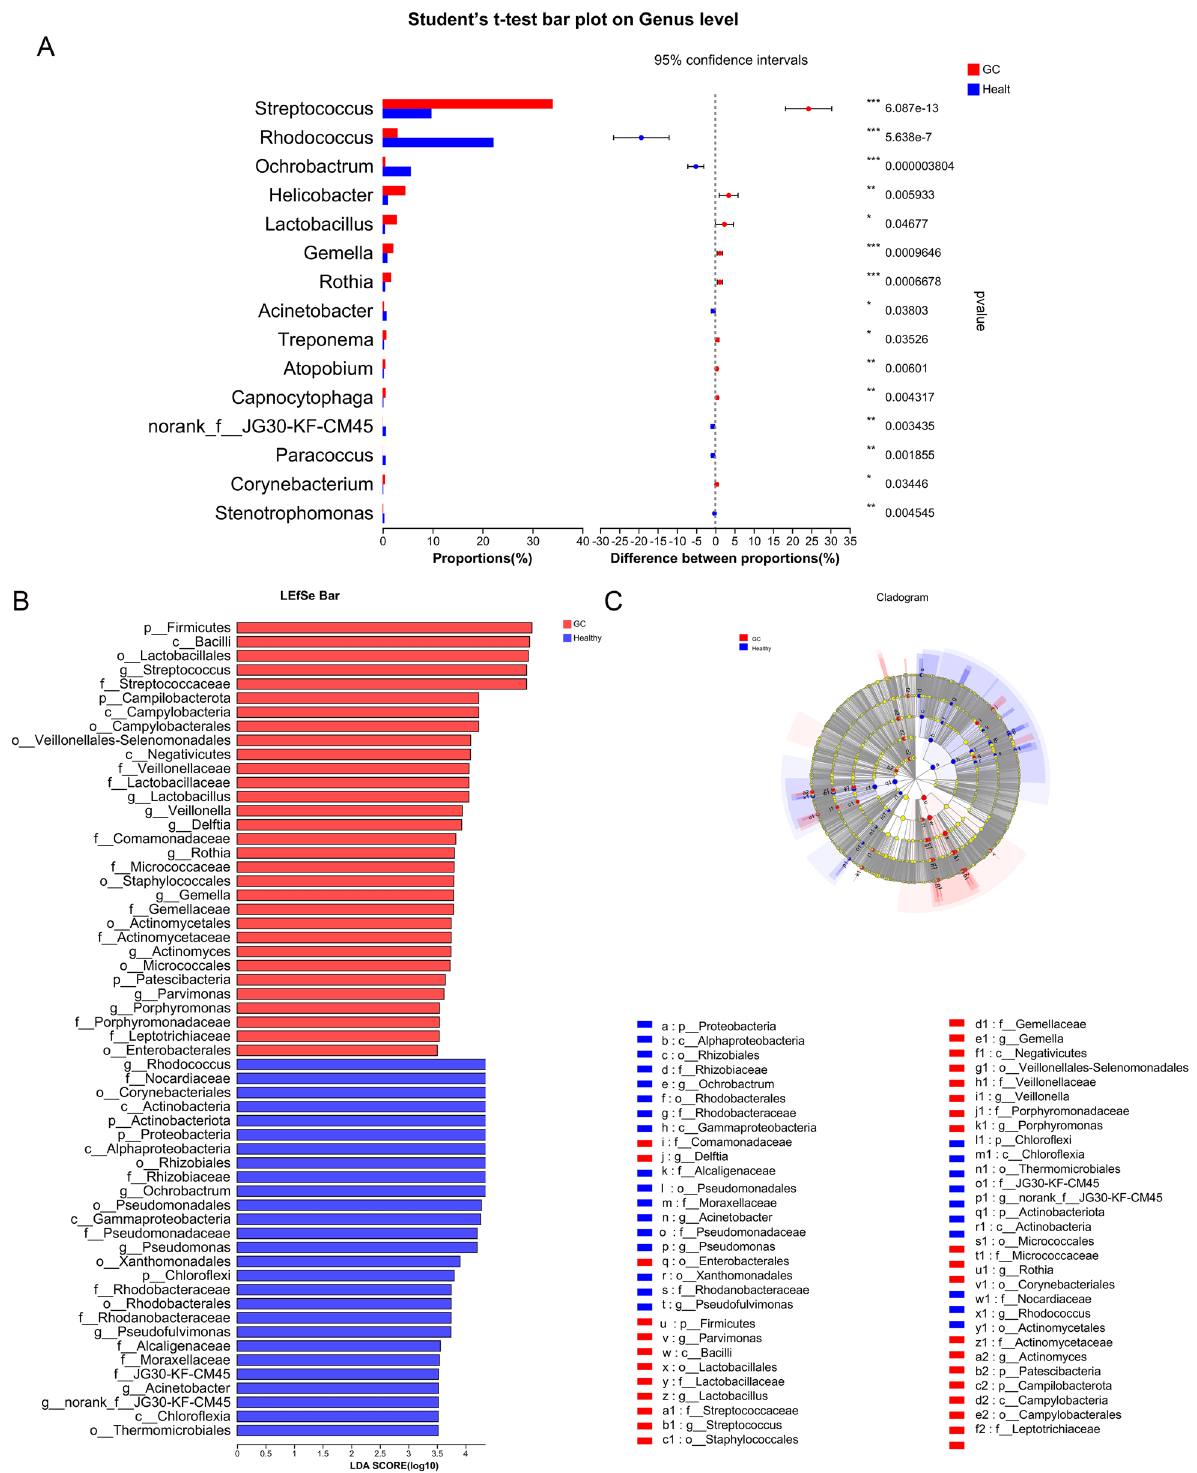
Fig. 2 Multispecies difference test bar chart and diagram of different microflora between the two groups. A Student’s t test was used to test the hypothesis of species between the microbial communities of the two groups and evaluate the significance level of species abundance differences. P < 0.05 indicates a sig- nificant difference. The closer the line is to the middle, the smaller the standard deviation, and the better the central tendency. B The LDA score was obtained by linear regression analysis, and the greater the LDA score was, the greater the impact of bacterial abundance on the difference effect. An LDA score of more than 2 indicates a statistically significant difference (P < 0.05). C The graph shows LEfSe multistage species from the inner to the outer circle and represents the phylum, class, order, family, genus, and species of different unit levels. Different color nodes indicate the microbial groups that were significantly enriched in the corresponding groups and had a significant influence on the differences between groups. The pale-yellow nodes indicate the microbial groups that had no significant difference among different groups or had no significant effect on the difference between